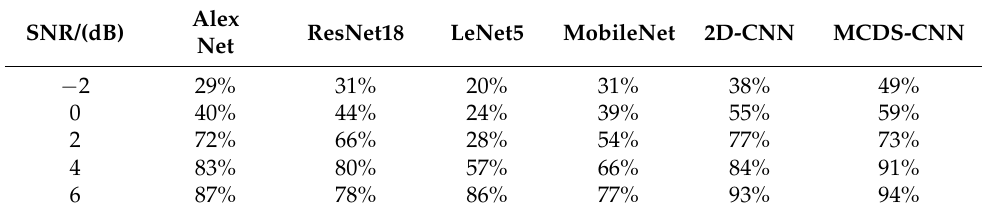
Table 9. Accuracy of the proposed model MCDS-CNN, and other five models on data set B with different SNR.